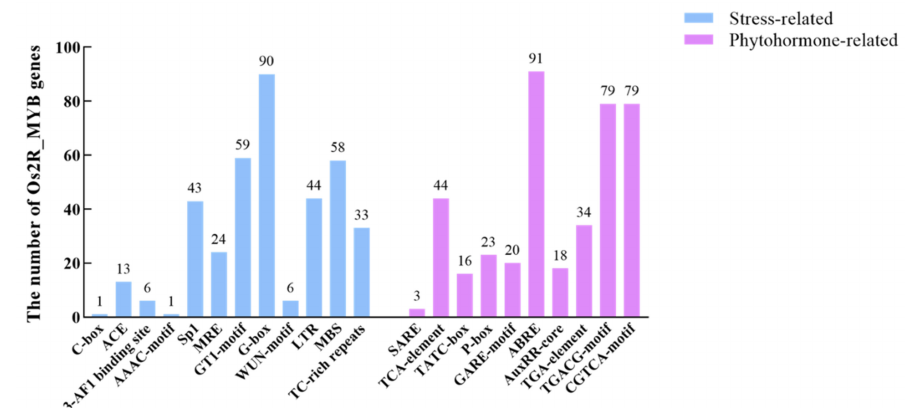
Figure 6. Statistical analysis of the cis-elements in 2000 bp regions upstream of Os2R_MYB genes. The bar chart shows the number of Os2R_MYB genes with various cis-acting elements in 99 Os2R_MYB genes. The light blue and purple bars represent stressed-related and phytohormone-related cis-acting elements, respectively.